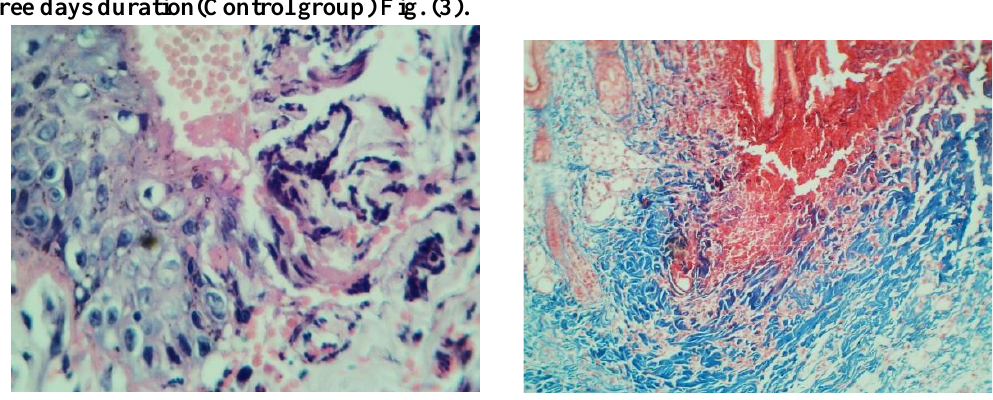
Figure 2: View of Myrrh oil group at day 1showed A: Epithelial cutting edge and migration of basal cell , H&E,X40 . B: showed infiltration of Inflammatory cells in dermis as black points,H&E,X40. Three days duration(Control group) Fig. (3).